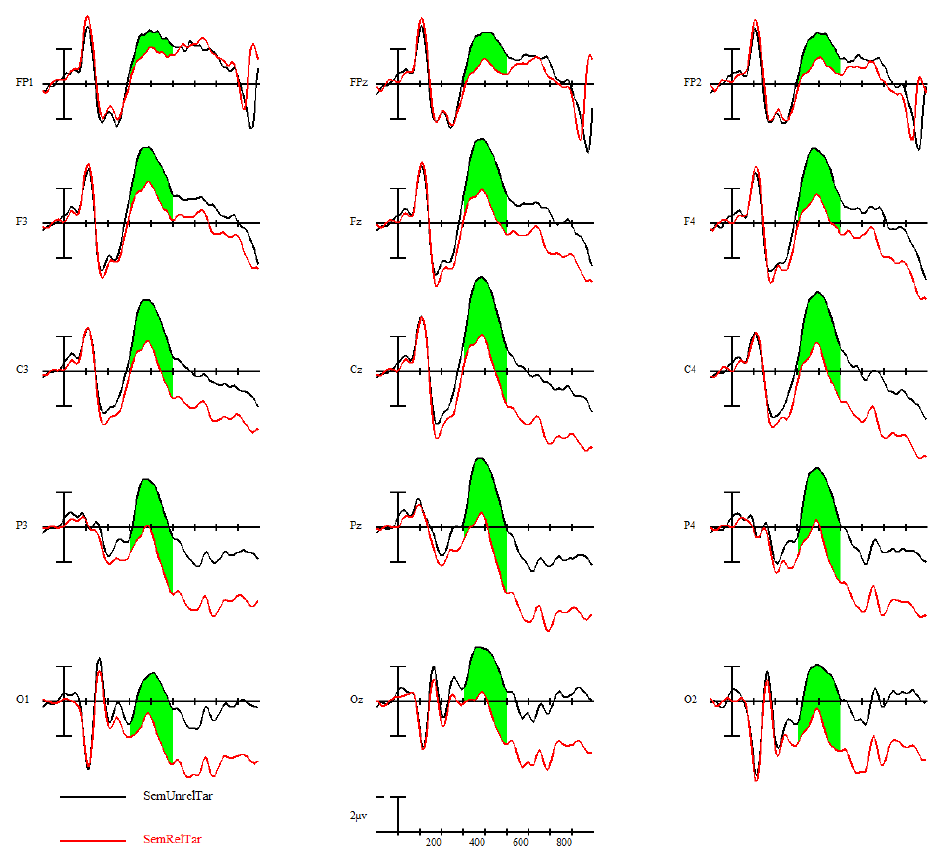
Figure 6. Semantic priming effect (related = black, unrelated = red) across all participants. Brain Sci. 2019 , 9 , x FOR PEER REVIEW